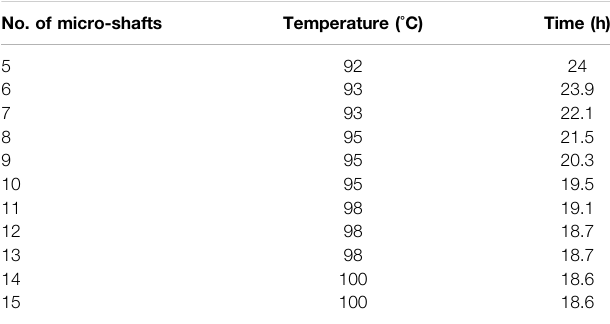
TABLE 4 | The variation of required time to reach the maximum temperature vs. the number of micro-shafts in KF solution (1 molL -1 ). No. of